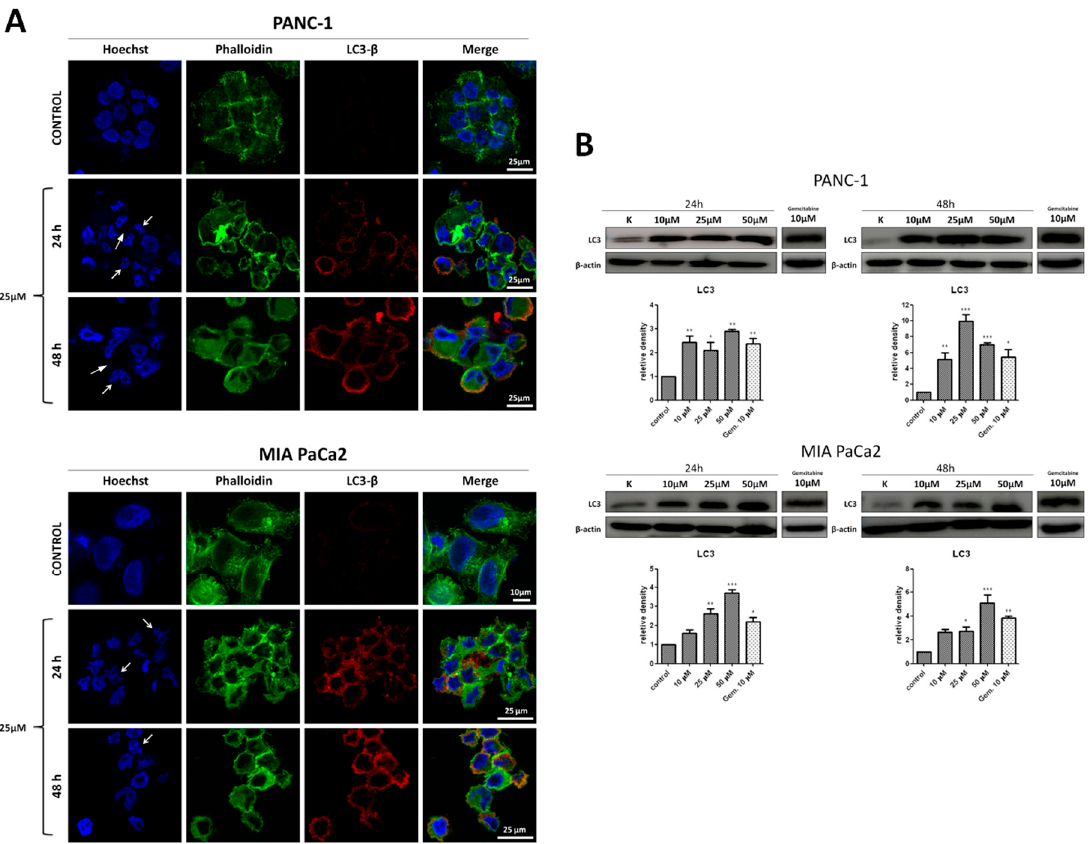
Figure 7. Morphological features and the expression of LC3 protein following incubation of cancer cells with T1. ( A ) Immunocytochemical staining of PANC-1 and MIA PaCa2 cells exposed to T1 (25 µ M) for 24 and 48 h. ( B ) Western blot analysis of LC3 expression in PANC-1 and MIA PaCa2 cells exposed to T1 (1–50 µ M) for 24 h and 48 h. Gemcitabine was used as a positive control. β -actin was used as an internal control. Results are given as mean ± SD of 3 separate determinations. * p < 0.05; ** p < 0.01; *** p < 0.001, as compared with untreated cells.